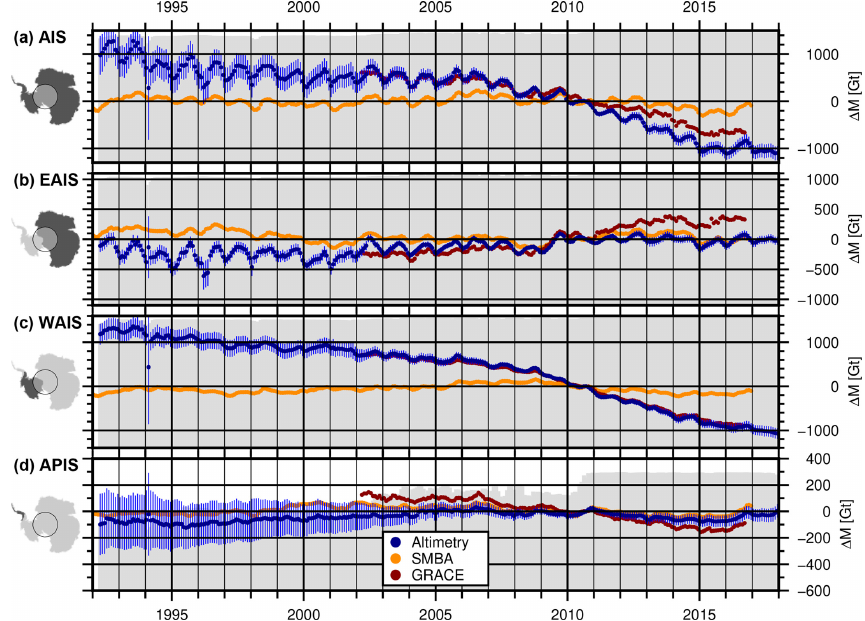
Figure 11. Mass change of the Antarctic Ice Sheet north of 81.5 ◦ S (a) and the three subregions ( b : EAIS, c : WAIS and d : APIS) from our combined altimetric time series (blue), GRACE (red) and SMBA (orange). The error bars show the uncertainty estimate σ (cid:54) of the altimetry data according to Sect. S6.2. The gray color in the background displays the fraction of the area covered by altimetry (up to the top of the panel means